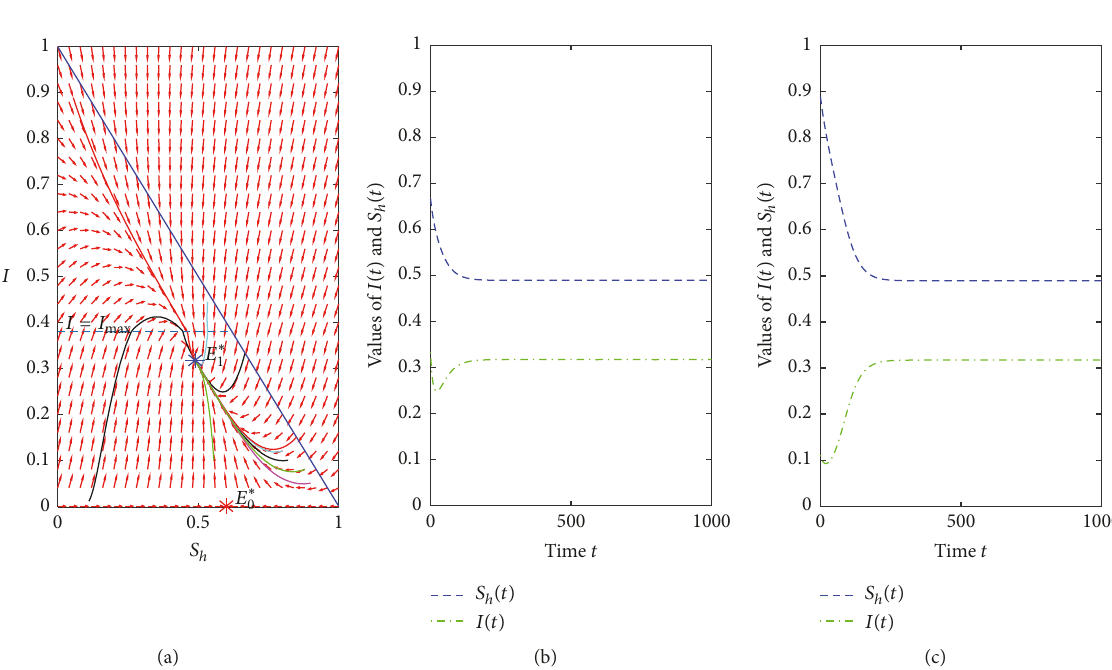
Figure 6: Trajectory figure and time plots of Example